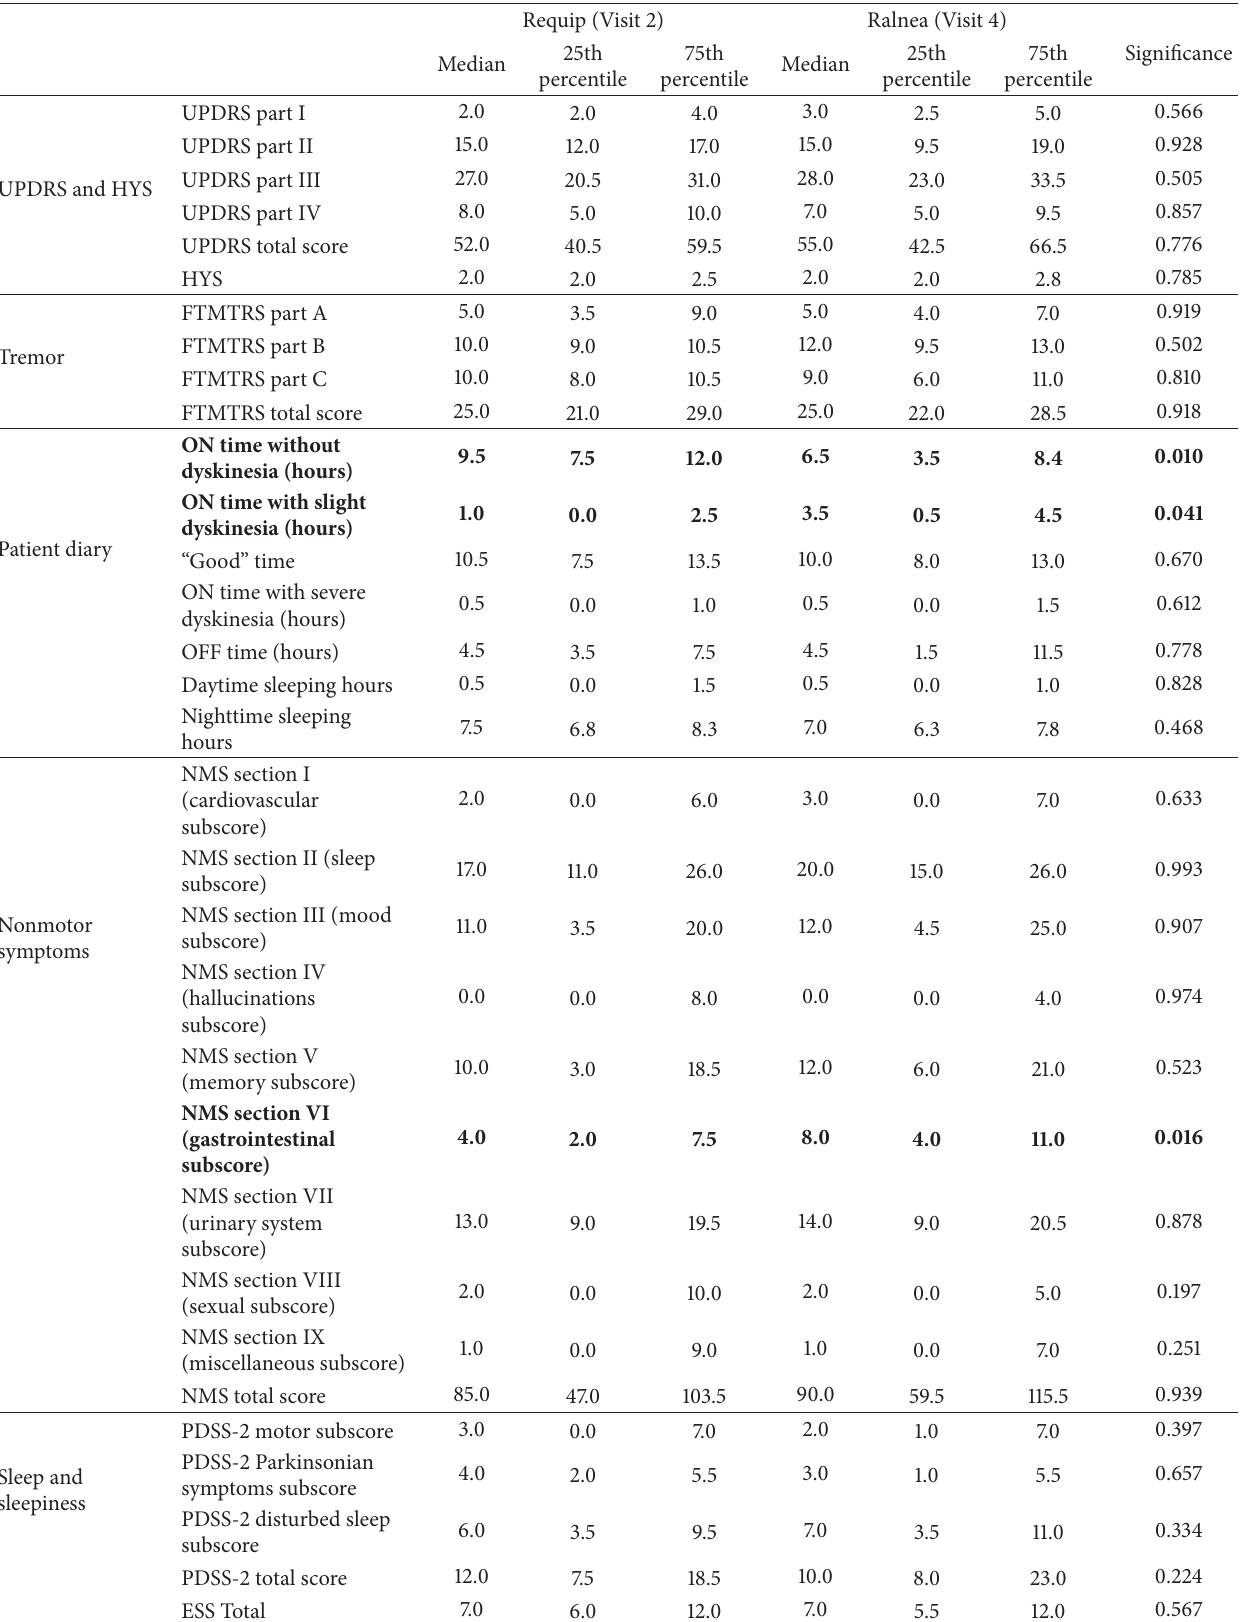
Table 1: Results of tests measuring various motor and nonmotor